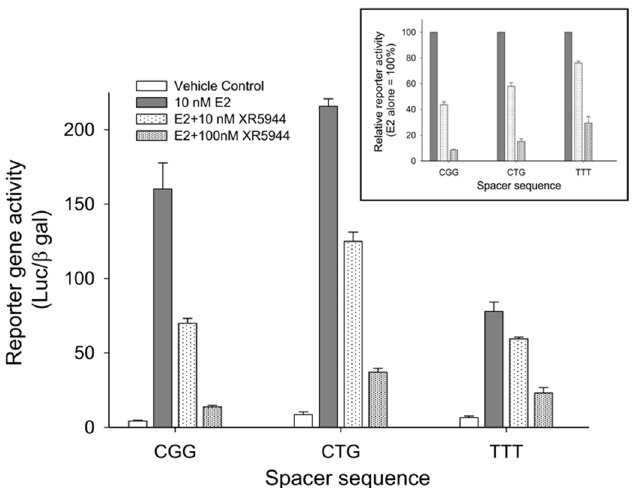
Figure 6. Effect of trinucleotide spacer sequence on XR5944 downregulation of ERE-promoted genes. XR5944 showed greatest suppression of CGG-containing ERE promoters, followed by CTG and TTT spacers, respectively. Copy from Figure 4A, Sidell 2011. This article was published in J. Steroid Biochem. Mol. Biol. 2011, 124 (3–5), Sidell, N.; Mathad, R.I.; Shu, F.; Zhang, Z.; Kallen, C.B.; Yang, D. Intercalation of XR5944 with the Estrogen Response Element Is Modulated by the Tri-Nucleotide Spacer Sequence between Half-Sites. p121–127. Copyright Elsevier (2011).